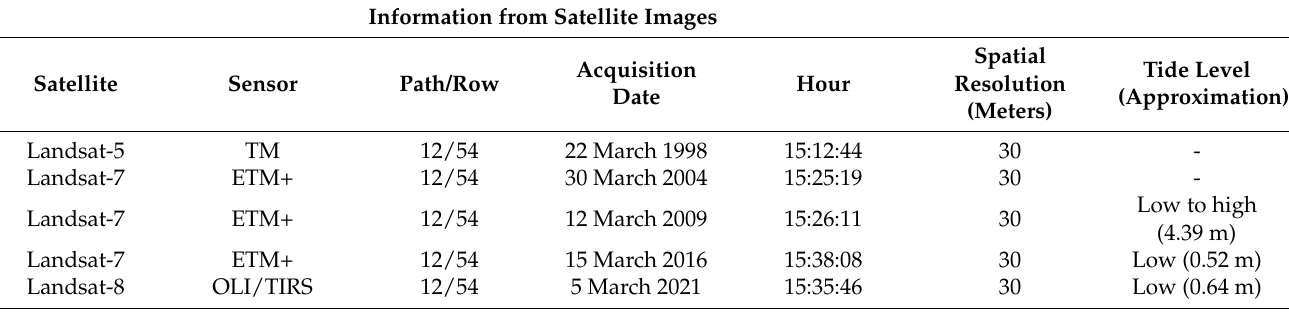
Table 2. Summary of data from the satellite images. Information from Satellite